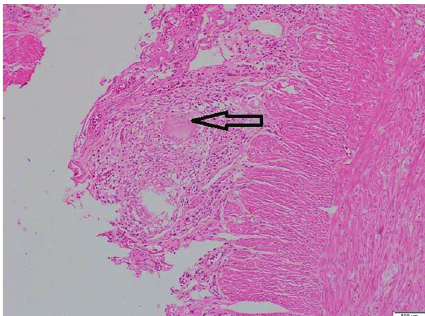
Figure 3: High-power view ( × 400) of the serosa and the meso- appendix shows numerous granulomata composed of epithelioid cells, Langerhans giant cells, and lymphocytes with central spotty caseous necrosis. H&E stain. The black arrow points at caseating granuloma.